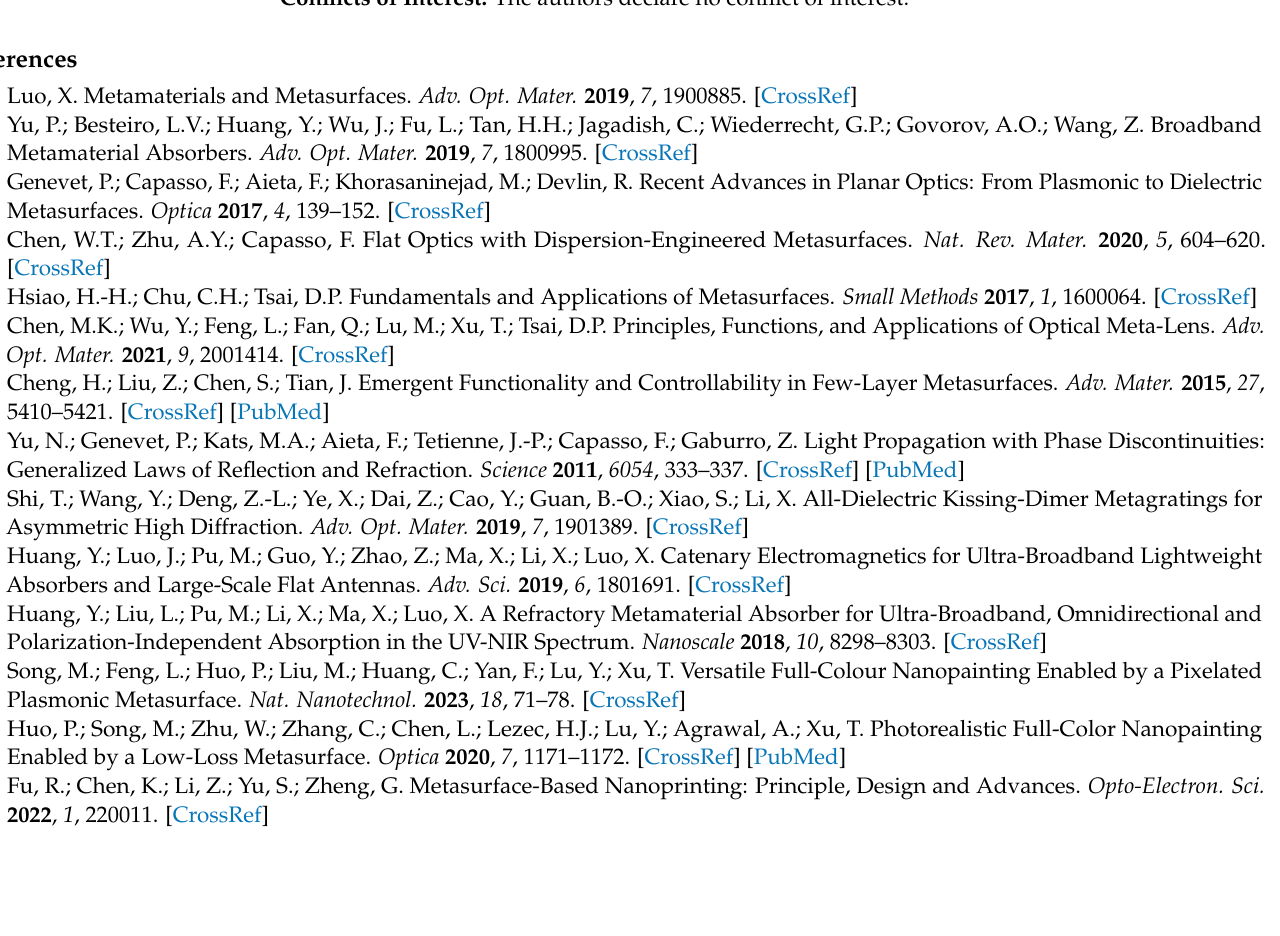
Figure S3: The schematic illustration for the multi-focus metalens. Figure S4: The schematic illus- tration for the multistate vortex beam generator. Figure S5: A feasible fabrication process for the designed sample. Figure S6: Schematic illustration of the measurement setup. Table S1: Geometric parameters and corresponding optical responses in A- and C-